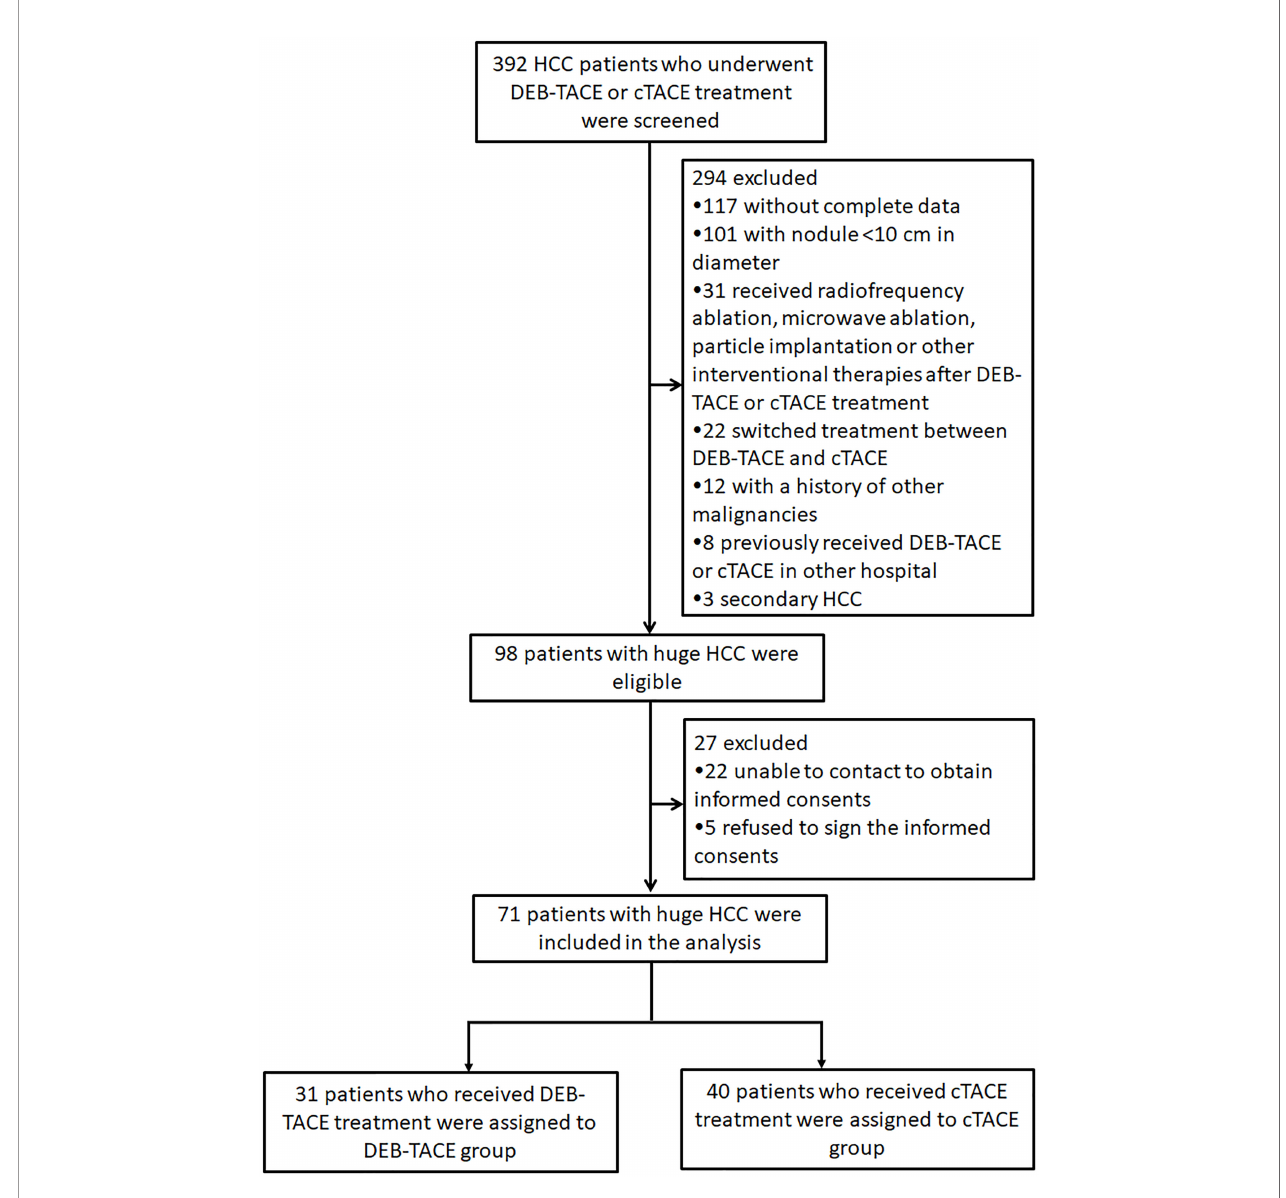
FIGURE 1 | Study fl ow. HCC, hepatocellular carcinoma; DEB-TACE, drug-eluting bead transarterial chemoembolization; cTACE, conventional transarterial